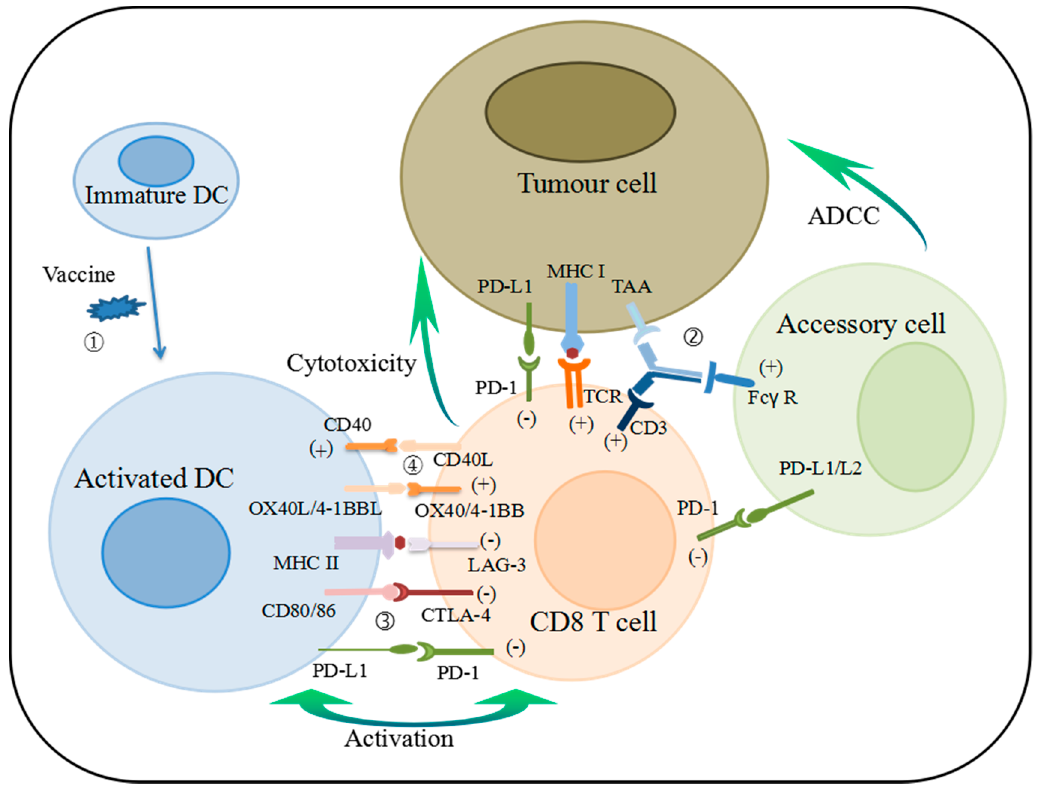
Figure 1. Schematic of action of selected immunotherapies in breast cancer. ① Vaccines initiate an immune response by providing target antigens to DCs and triggering their activation. Adaptive immune responses initiate at the lymph node through the interaction of T-cells and DCs. ② BsAbs can activate T-cell and accessory cell and cause tumor lysis by address TAA, CD3, and Fc γ -receptor of monocytes, macrophages, DCs, and NK cells simultaneously. ③ , ④ Activated DCs present antigen as well as immune checkpoints and costimulatory molecules to T-cells. These molecules shape the quality and magnitude of the T-cell response. DCs, dendritic cells; BsAbs, bispecific antibodies; TAA, tumor-associated antigen; NK, nature killer; MHC I, major histocompatibility complex class I protein; ADCC, antibody dependent cellular cytotoxicity; Accessory cell, include monocytes, macrophages, dendritic cells, and NK cells.